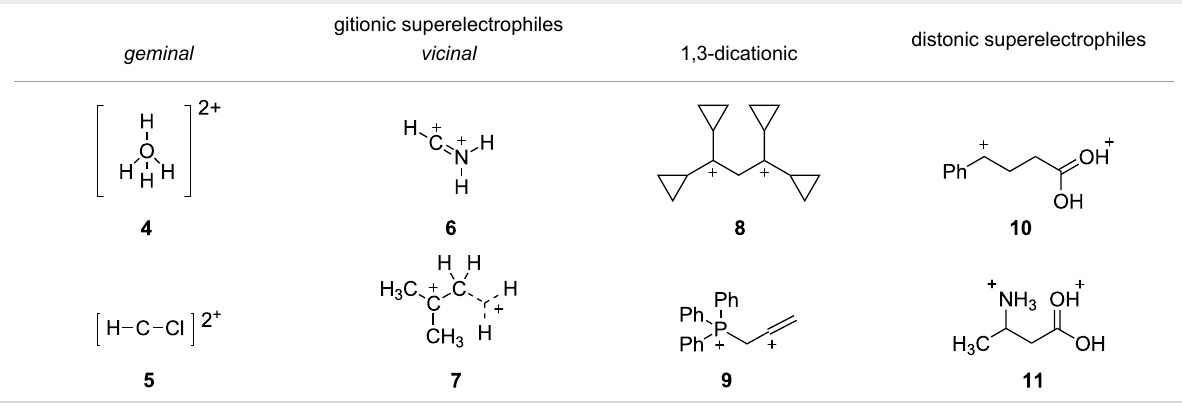
Table 1: Representative examples and categories of